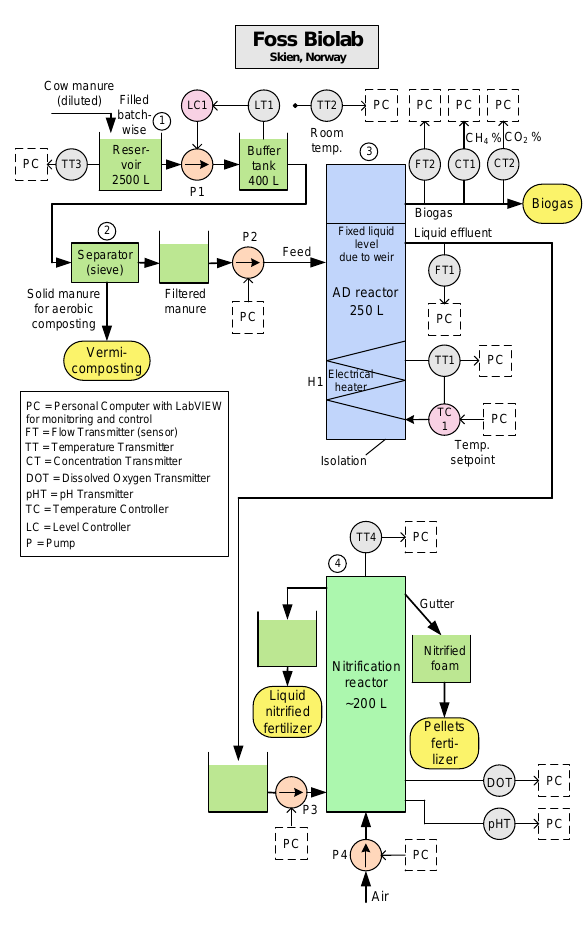
Figure 1: Piping & Instrumentation Diagram (P&ID) of the biological process line of the pilot plant at Foss Biolab, Skien, Norway. This paper concerns the AD reactor.